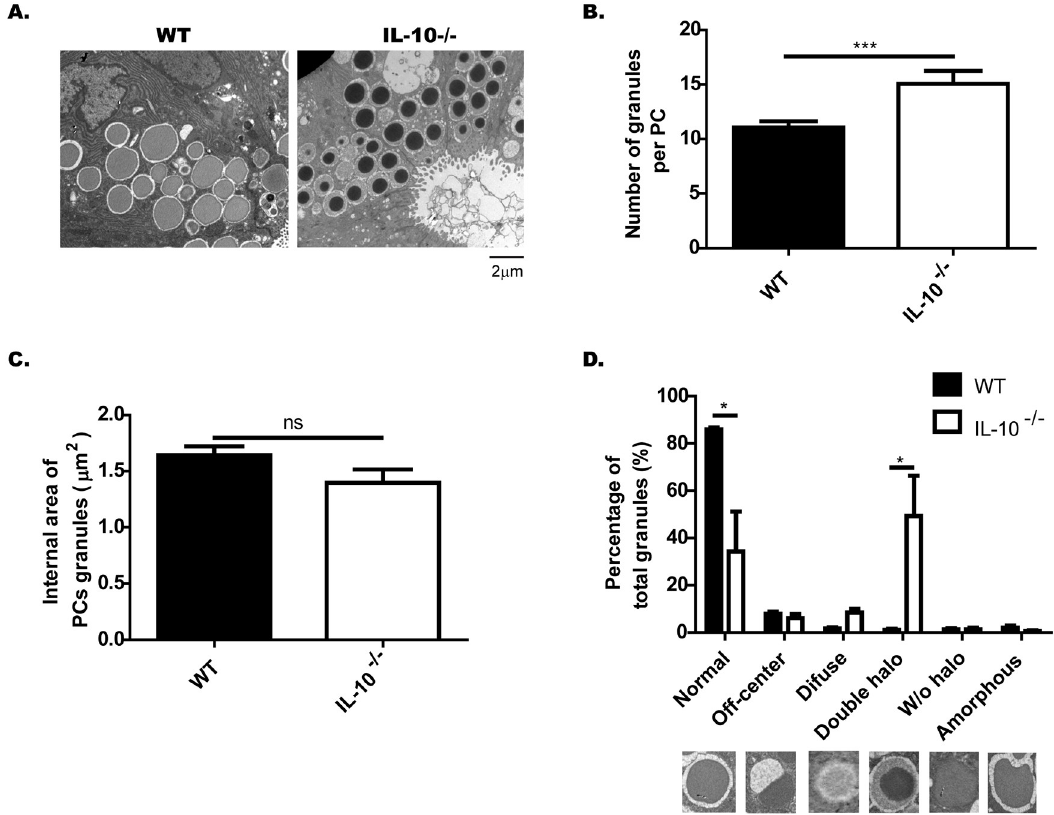
Fig 3. IL-10 -/- mice present abnormal Paneth cells granules. Paneth cell (PCs) granules of C57BL/6 and IL-10 -/- mice were evaluated by transmission electron microscopy (n = 3). (A) Representative images of PC granules from both strains (4200X, Scale is 2 μ m). (B) Number of granules per PC (t-student, ��� <p 0.001). (C) Area of the electrondense core of the PC granules. D) Classification of granules, according to their TEM morphology in: normal, off-center, diffuse, double halo, without halo and amorphous (n = 3 mice, 2-way ANOVA, post-hoc Bonferroni � p<0.05).